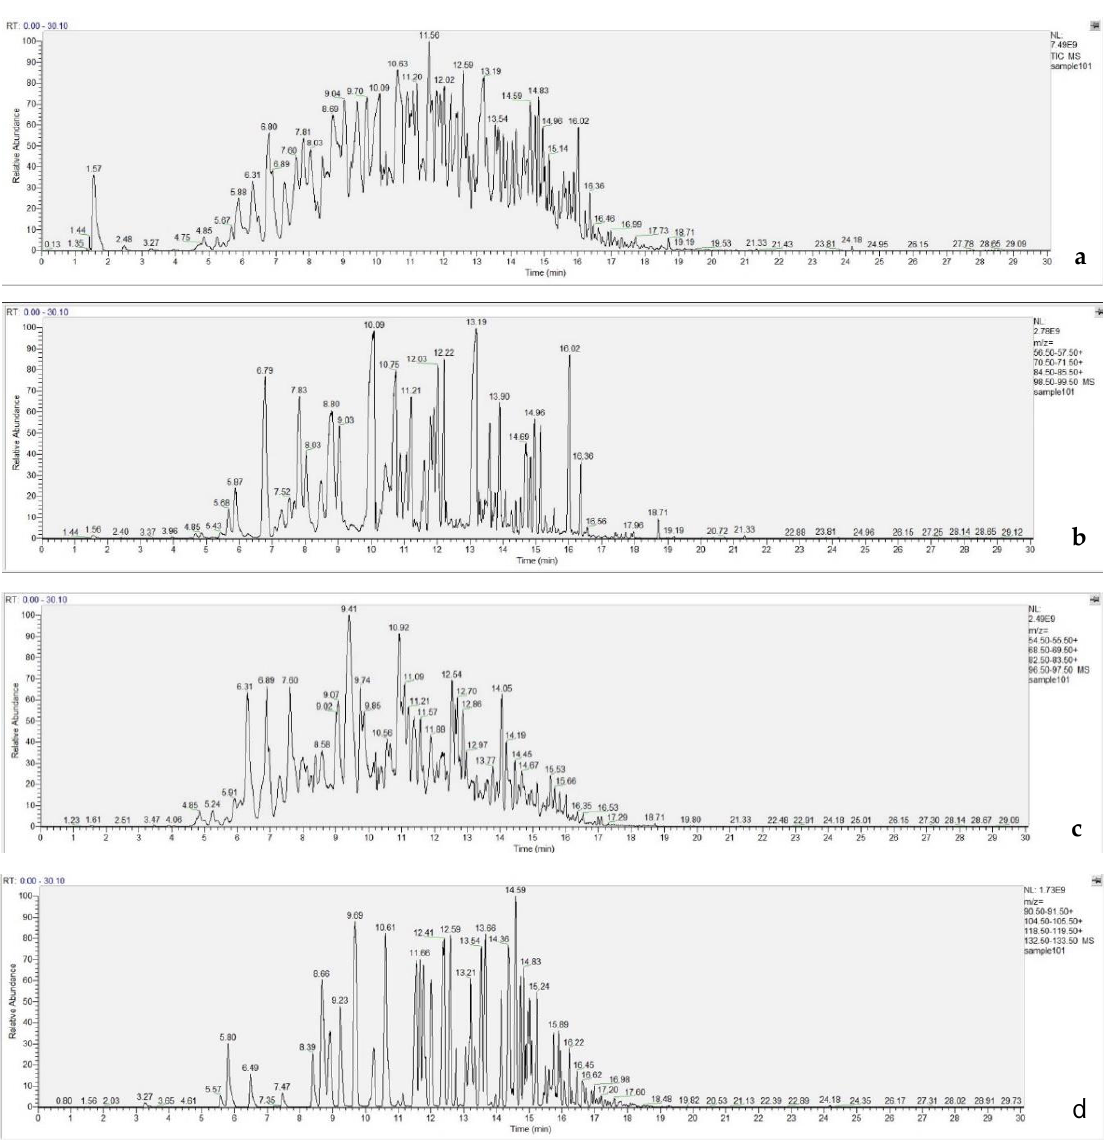
Figure 1. GC-MS extracted ion data related to neat gasoline. ( a ) Total ion chromatogram; ( b ) extracted